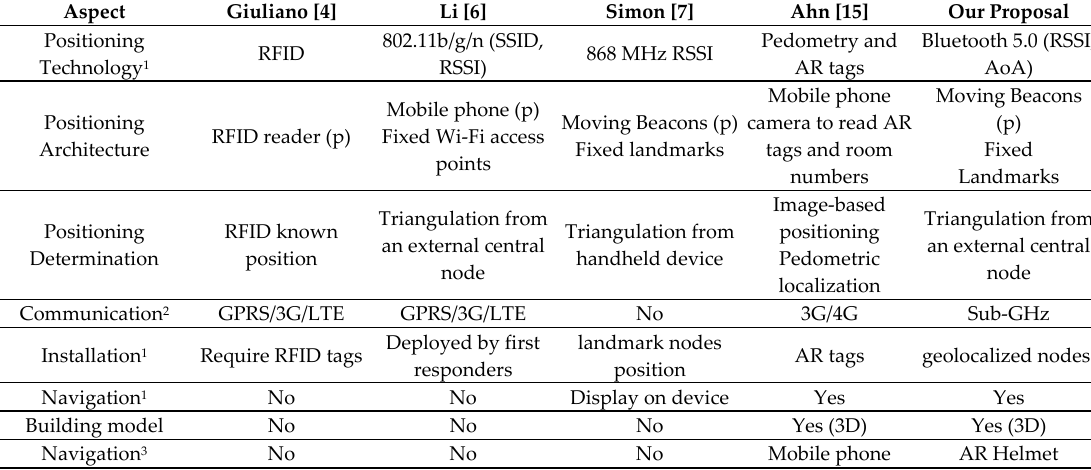
Table 1. Emergency Rescue